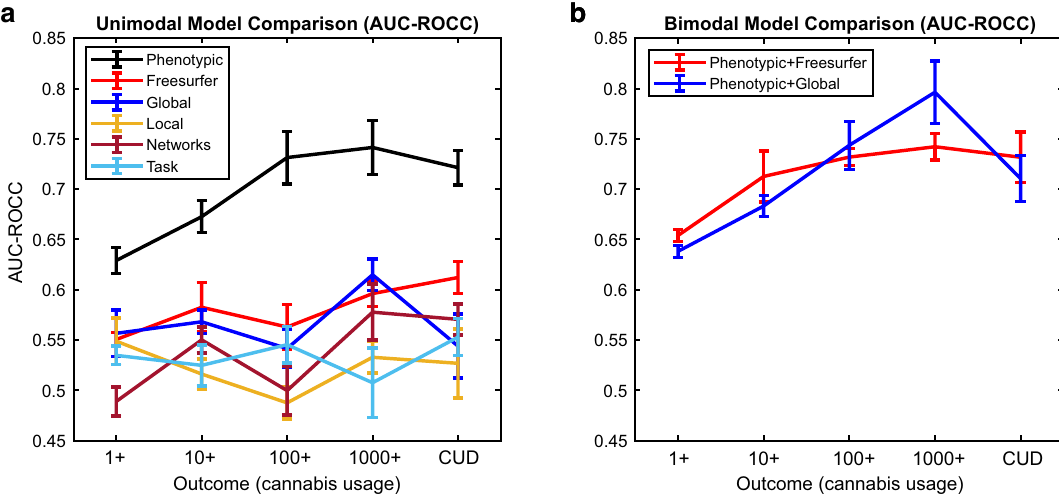
Figure 1. Area under the Curve of the Receiver Operating Characteristic Curve (AUC-ROCC) was used to quantify the classification performance of ( a ): Six unimodal models, and ( b ): Two additional multimodal models that combined the factors of the phenotypic model with the factors of the two best performing brain models. The phenotypic model performed better than any of the other unimodal models, and the inclusion of the two best sets of brain factors (Freesurfer & global efficiency) did not appreciably improve the performance of the phenotypic model. Error bars correspond to ± 1 Standard